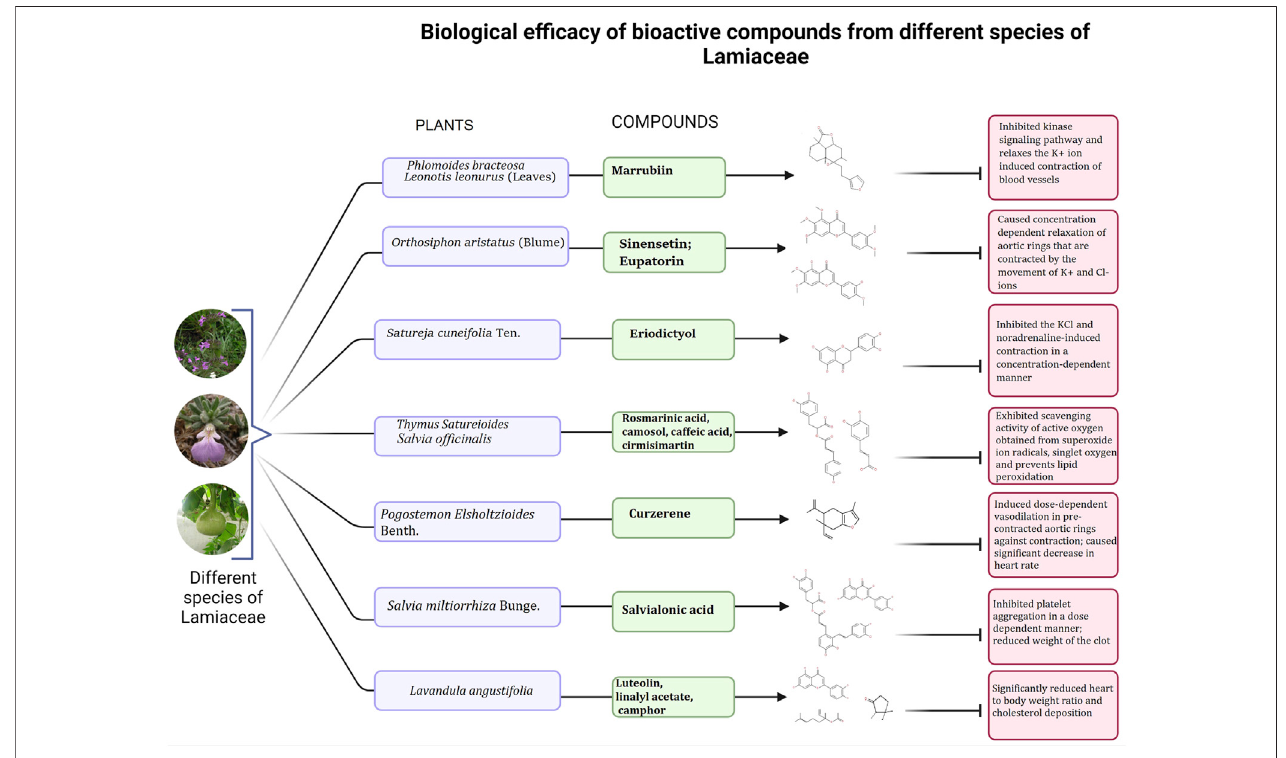
FIGURE 4 | Schematic representation of the mechanism of action of the bioactive compounds of Lamiaceae in the treatment of CVDs (Figure made in Microsoft paint).